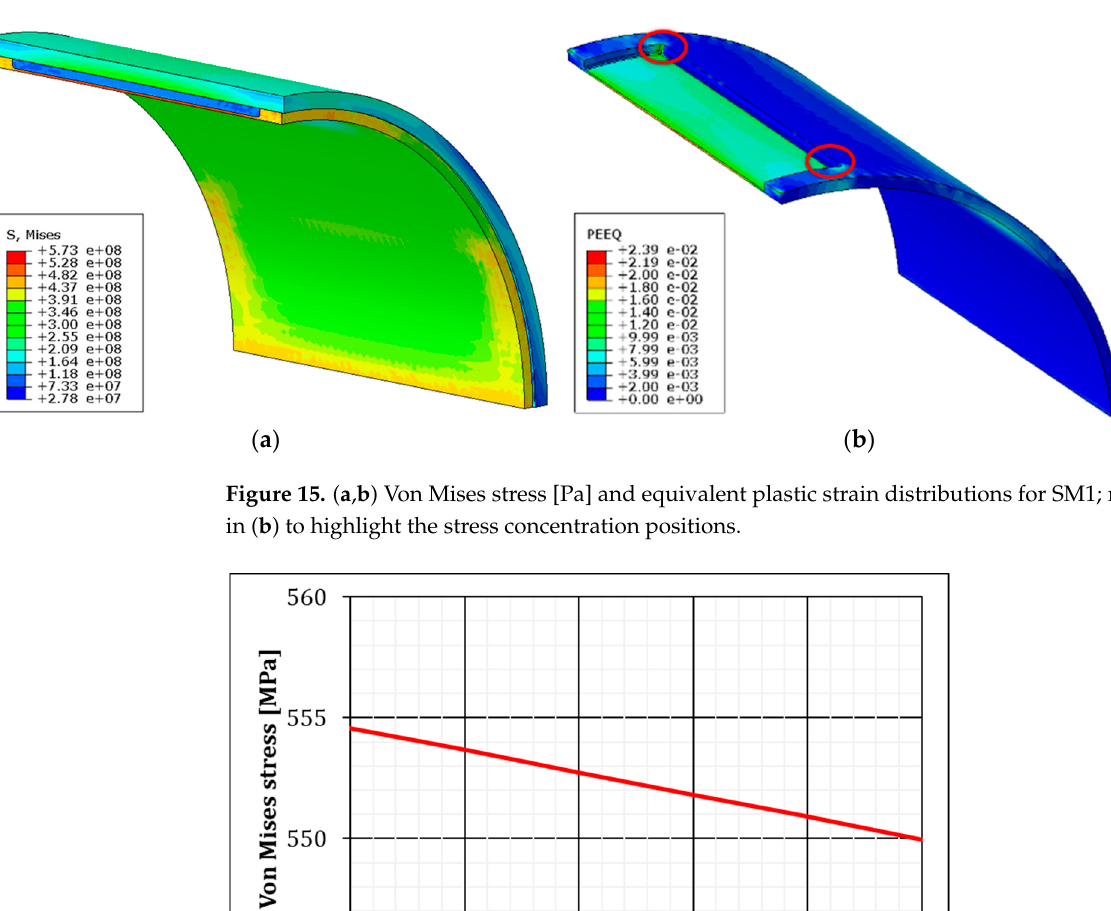
Figure 15. ( a , b ) Von Mises stress [Pa] and equivalent plastic strain distributions for SM1; red cir- cles in ( b ) to highlight the stress concentration positions.